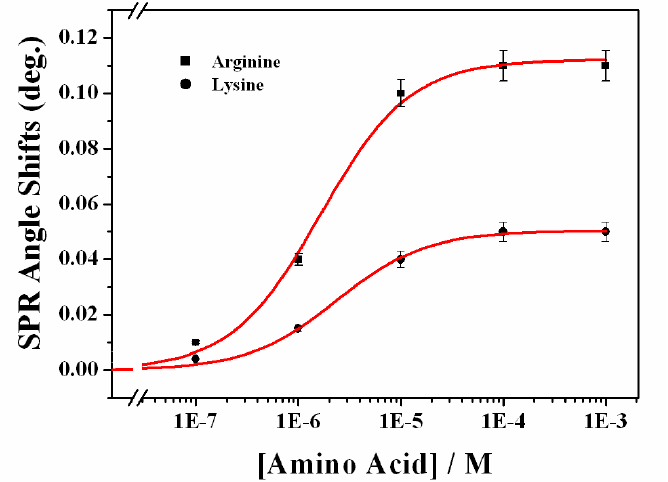
Figure 4. Dose-response curves of sensor chip immobilized by calix[4]crown SAM, represented by SPR angle shifts according to the interaction with arginine (rectangular) and lysine (circle). Solid lines represent the result of one-site binding fitting.